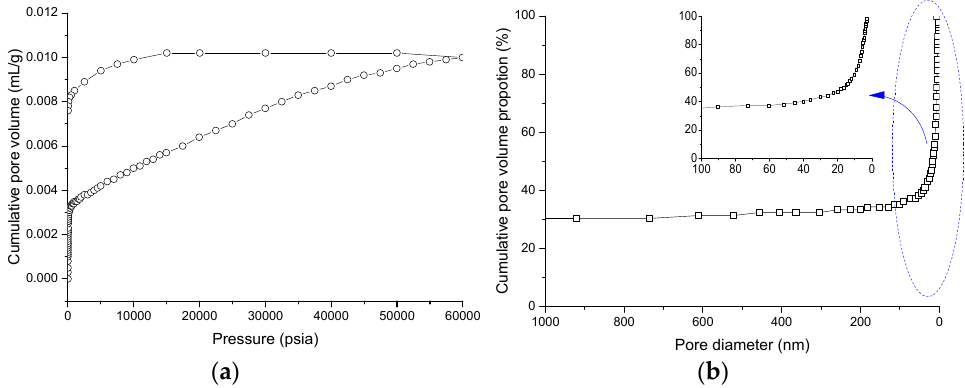
Figure 3. Micropore size analysis. ( a ) Graph of pore volume vs. pressure showing Hg hysteresis and retention; ( b ) pore diameter distribution.